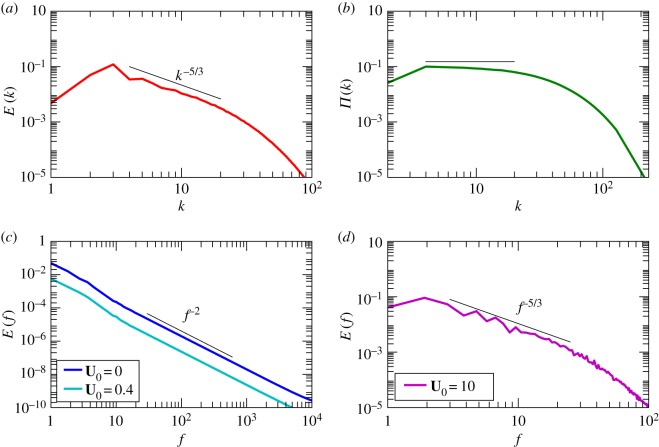
For hydrodynamic turbulence simulation with Re≈1100, and U0=0 and U0=10z^: (a) energy spectra and (b) energy fluxes are the same for both the flows; they follow Kolmogorov’s model. (c) Frequency spectra E(f)∼f−2 for U0=0 and 0.4; (d) For U0=10, E(f)∼f−5/3 consistent with Taylor’s hypothesis.